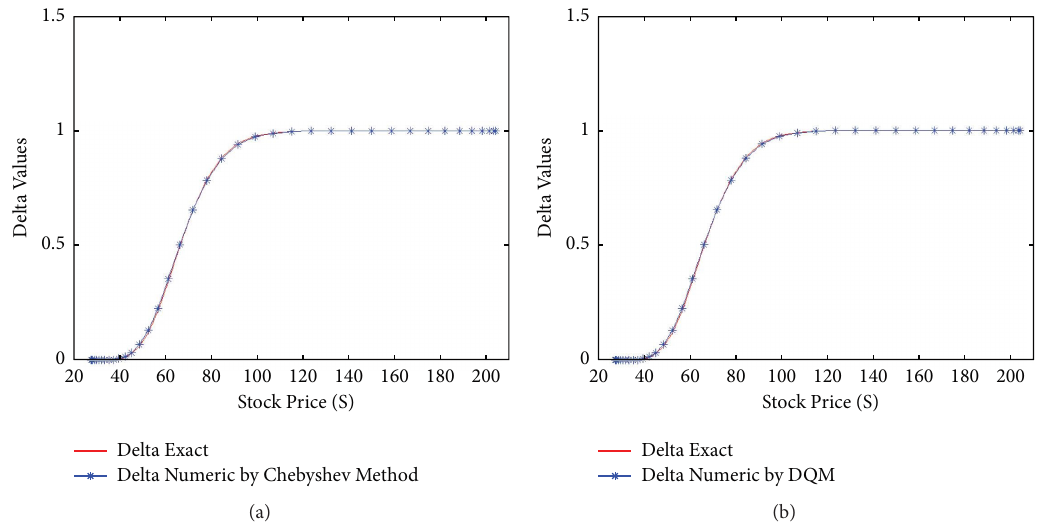
Figure 12: Here, we plot exact and numerical values of delta at time t � 0. (a) is for the Chebyshev method, and (b) is for the DQM.